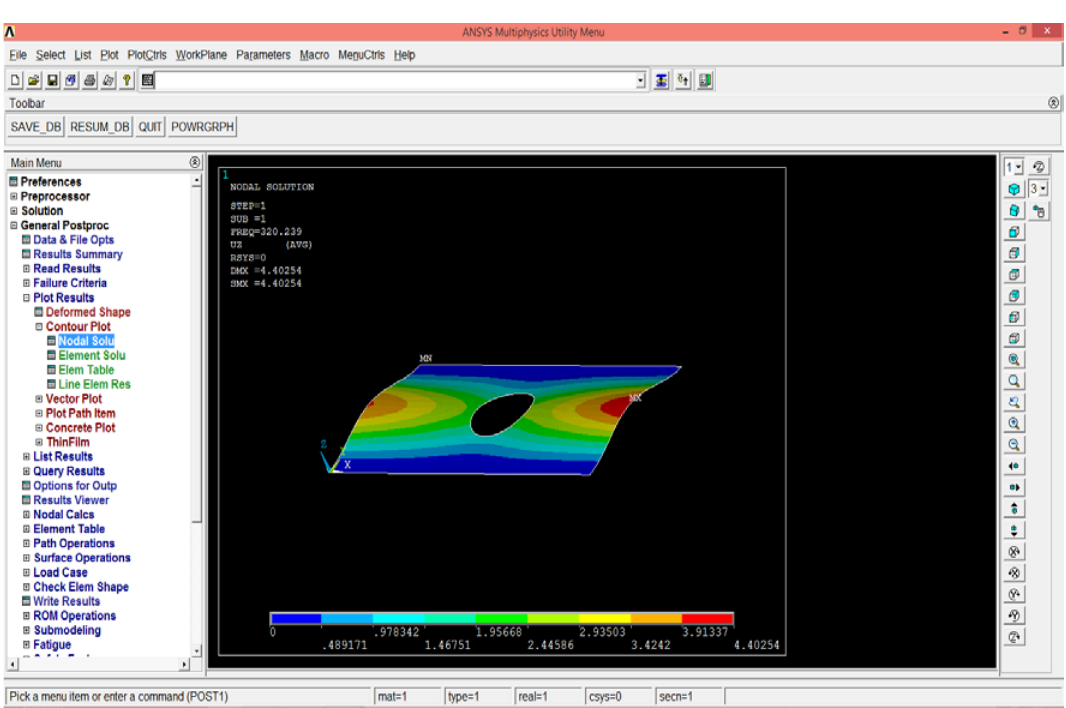
Figure 6: Plate with circular hole CFCF condition